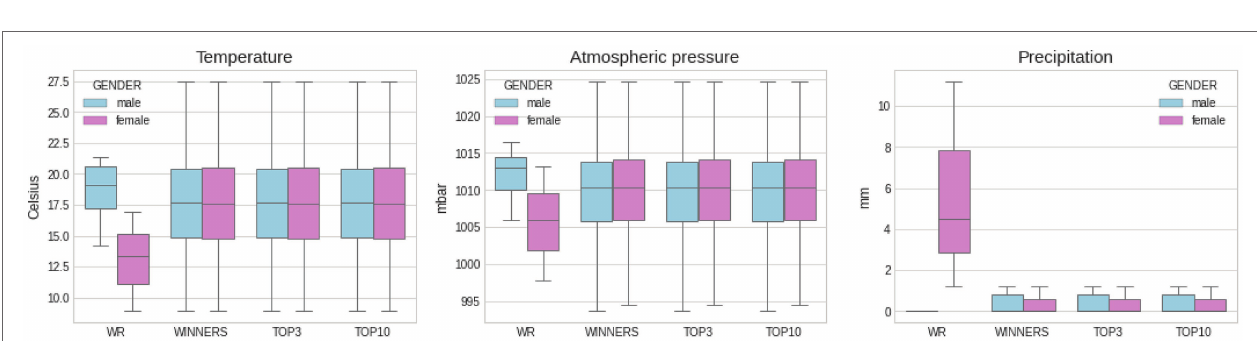
FIGURE 2 | Comparative analysis of weather conditions (sunshine and cloud cover in hours) on WR marathon performances and elite marathon performances (winner, top three, and top 10) by gender, with SD. About 95% CI was used to create the boxplots. Statistical difference between WR men and women for both sunshine and cloud cover ( p < 0.05).